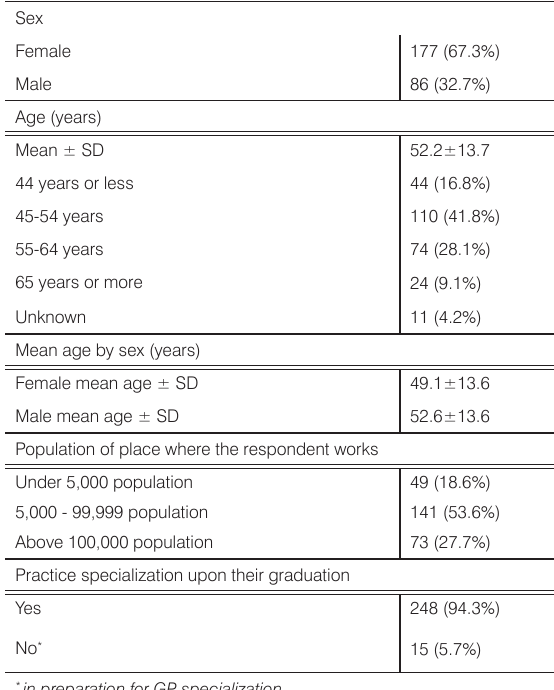
Table 1. Demographic characteristics of respondents